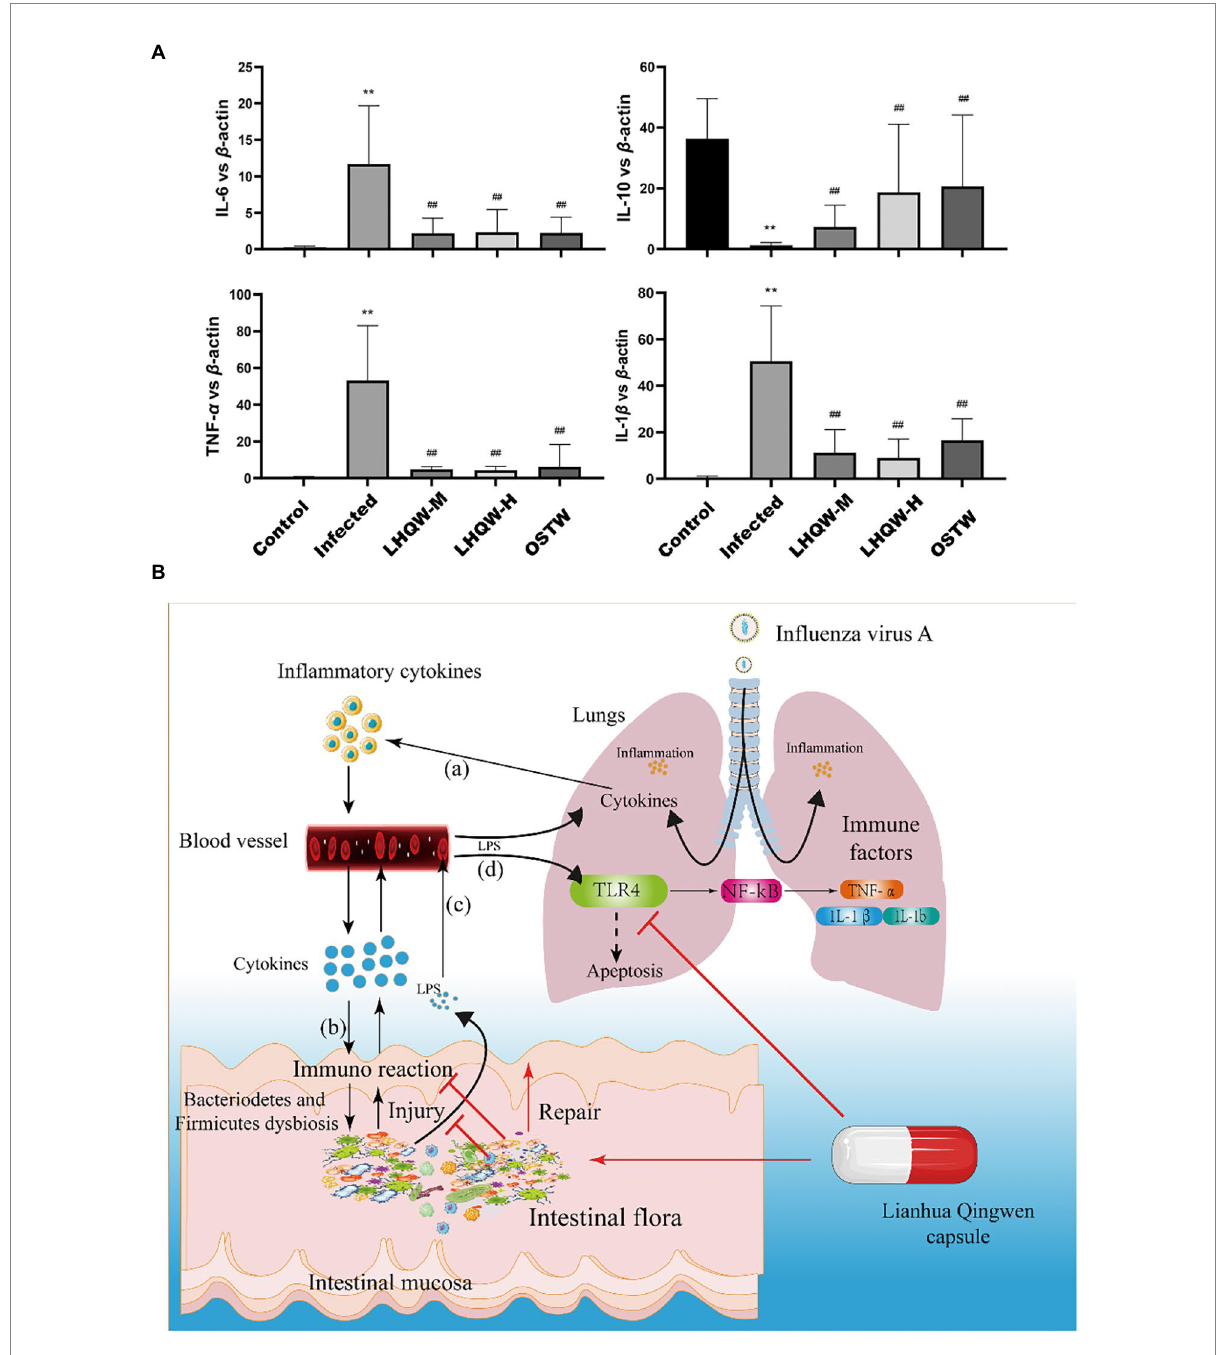
FIGURE 9 (A) qRT-PCR detection of inflammatory factors (IL-6, IL-1 β , IL-10, TNF- α ) in the mouse lung tissue. Compared with control group, * p < 0.05, ** p < 0.01; Compared with infected group, # p < 0.05, ## p < 0.01. (B) The working model of LHQW capsule against influenza A virus infection. (a) The lung infected with influenza A virus induces an immune response in lung, leading to the release of inflammatory cytokines into blood. (b) The inflammatory cytokines from the blood enter the intestinal wall to induce the immune response, resulting in intestinal wall injury. (c) The LPS from the intestine crosses the damaged intestinal mucosal barrier and enters the blood to activate the TLR4-mediated pathway in lung, causing the lung injury (d).